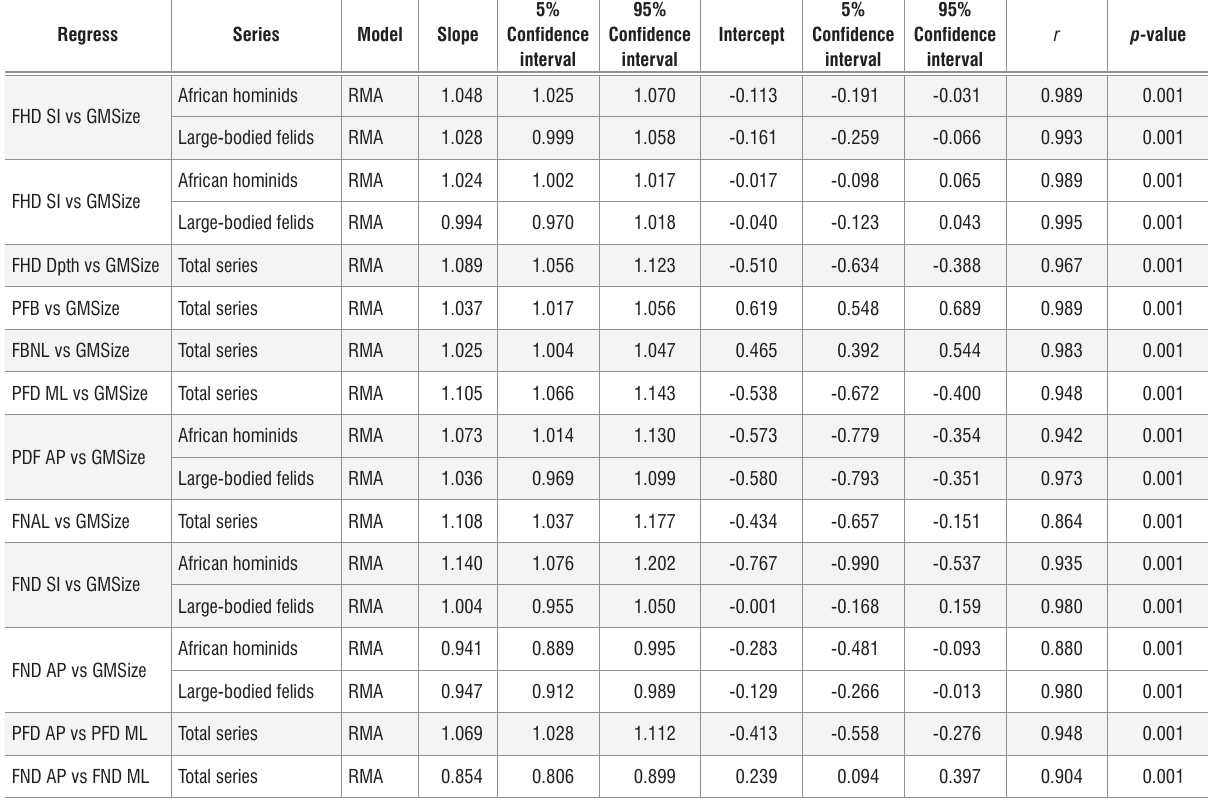
Table 5: Bivariate allometry equations for the proximal femoral dimensions